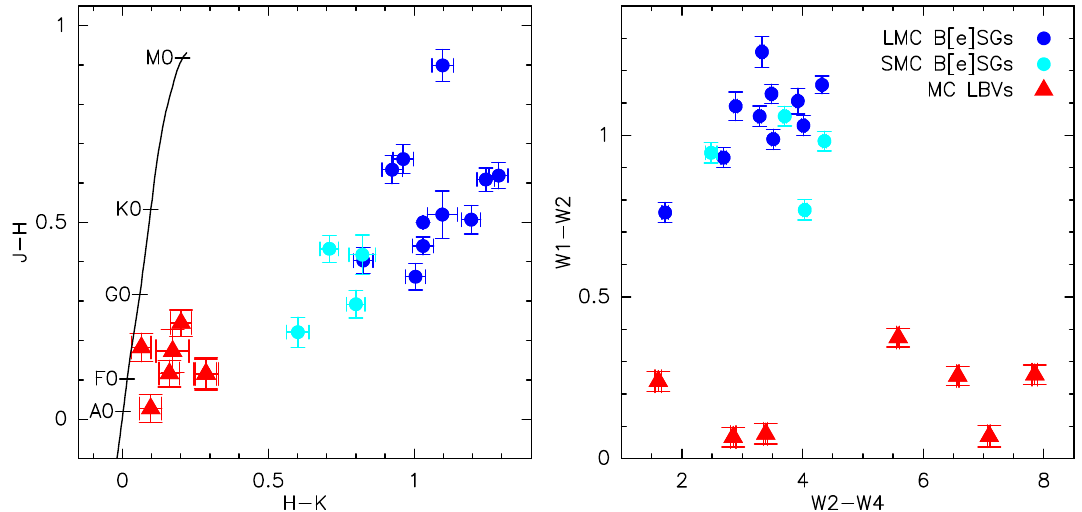
Figure 5. Demonstration of the separation of the B[e]SGs from the quiescent LBVs within the near-IR (J–H versus H–K diagram ( left )) and the WISE diagram (W1–W2 versus W2–W4 ( right )). Shown are the positions of the classical MC B[e]SG sample and of the MC LBV sample. IR colors of the objects are provided in Table3. The solid line represents the positions of regular supergiants with empirical colors taken from [106] for solar metallicity